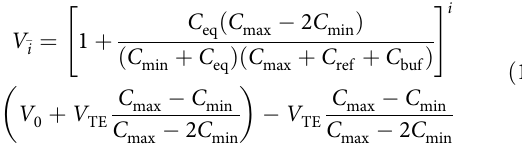
are considered ideal: given the high voltages of the circuit operation, the threshold of the diodes has no impact on the circuit operation. Figure 2b represents a simpli fi ed representation of the i th QV cycle of the Bennet doubler operation. Here Q var represents the instantaneous charge on the movable electrode of the TENG and V TENG the instantaneous voltage across the TENG terminals. This QV diagram starts from point A, when the TENG is already charged at its maximum capacitance C max and diodes D 1 and D 3